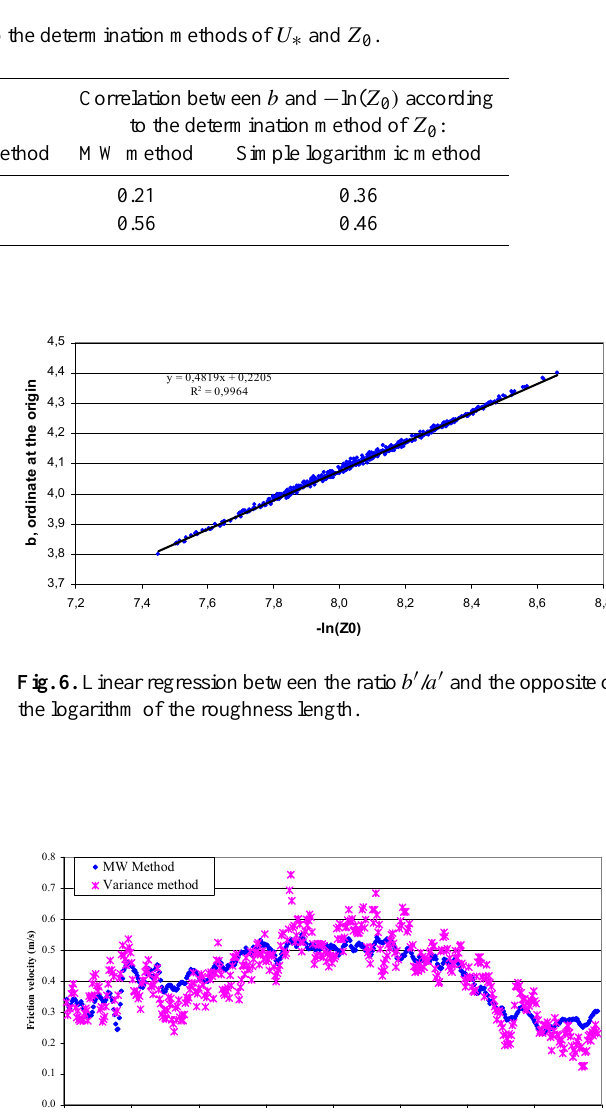
Figure 7.b: Friction velocity. Comparison between the statistical method MW and the variance method (Plot RT, 25 July 1997) 32